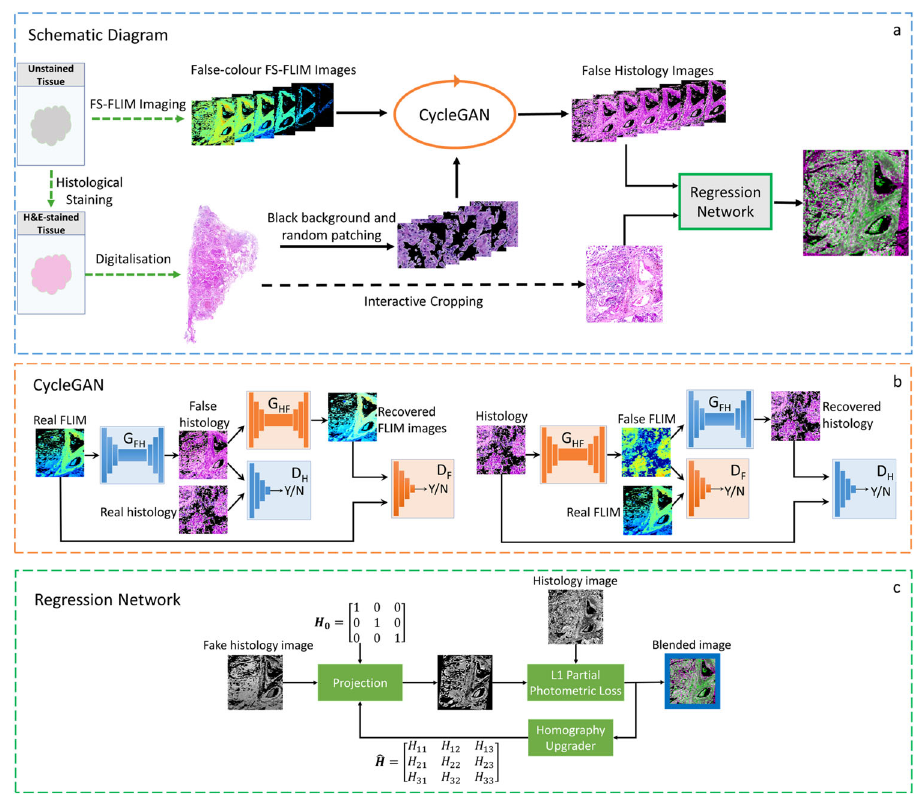
Fig. 9 Schematic diagram of the proposed method. a is the overall procedure of the method. After collecting the FS-FLIM images, they are input into the CycleGAN ( b ) to generate false histology images, in assistance with histology images. The output of the CycleGAN and the corresponding cropped histology patches are fed into a regression network ( c ) for the